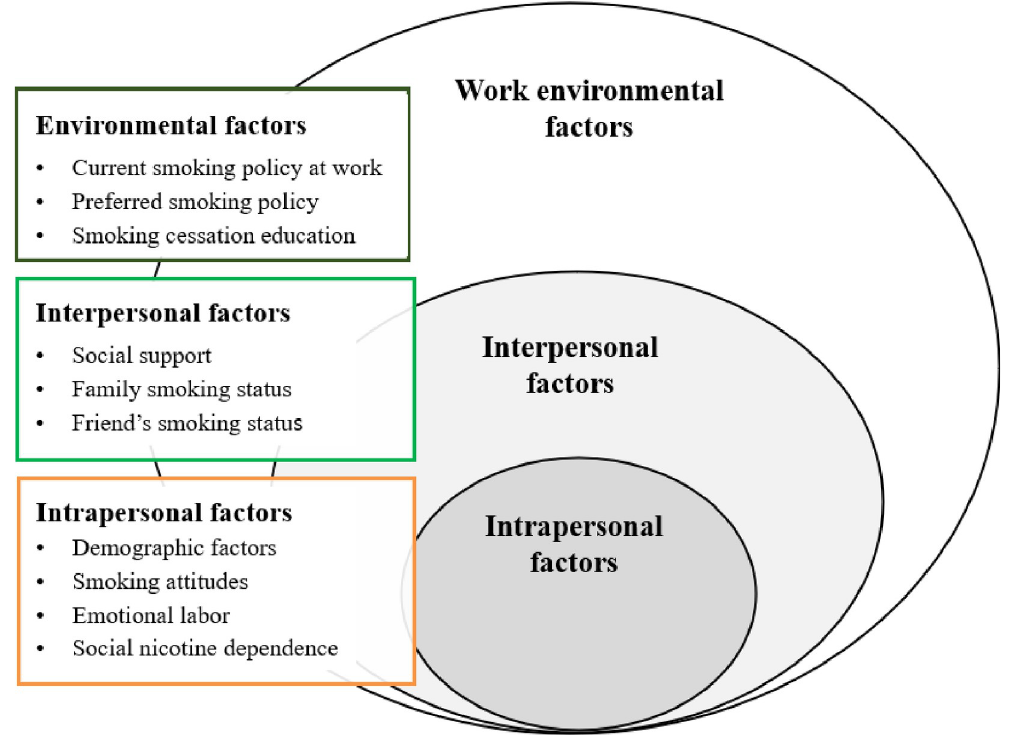
Fig 1. Ecological model for female smoking in call